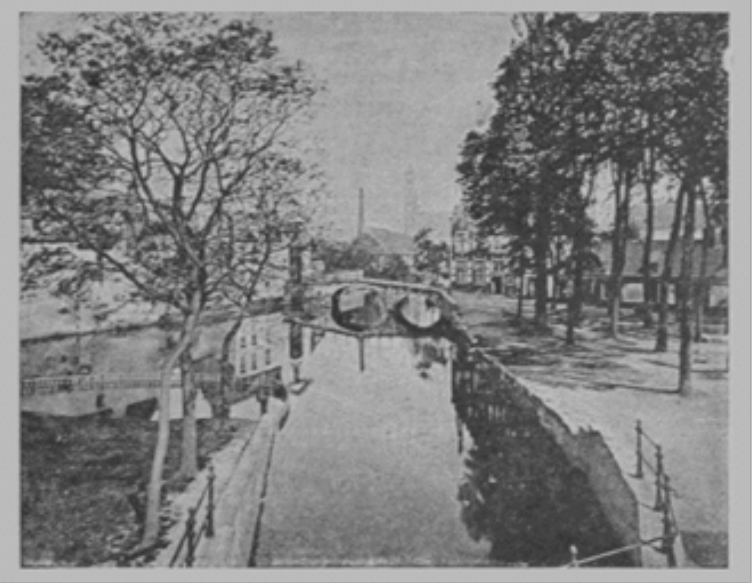
Figure 4. Anonymous. Photograph of Vineyard square and Begijinhof Bridge in Bruges La Morte